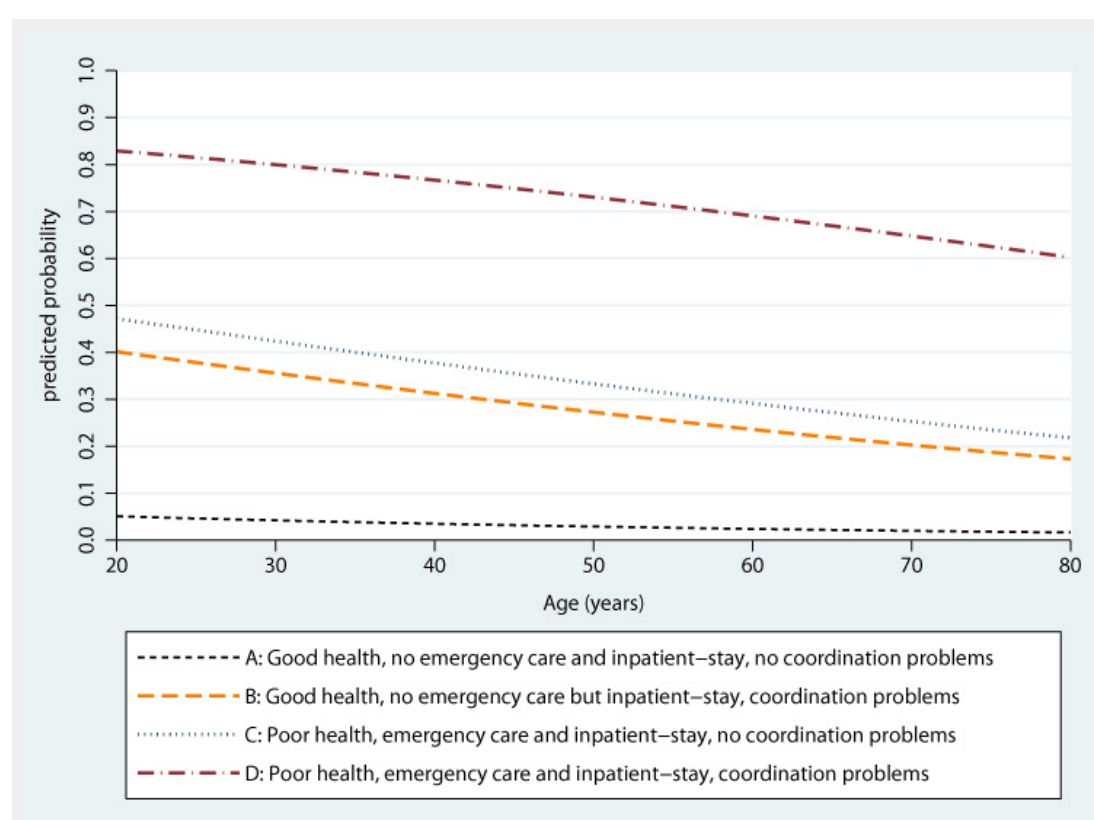
Figure 2 Predicted probability for any patient-reported error for four hypothetical patients (A-D), weighted